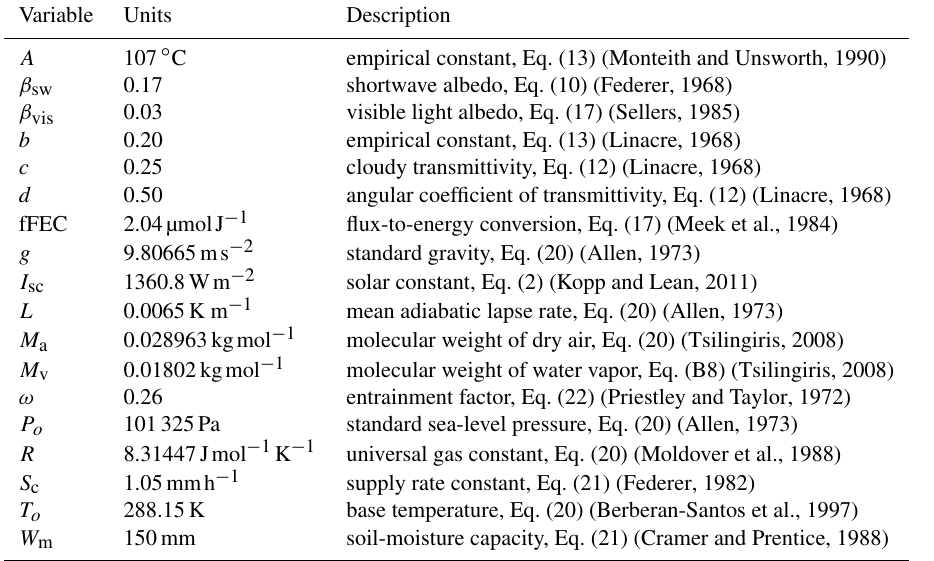
Table 2. Constants and Standard Values. Variable Units